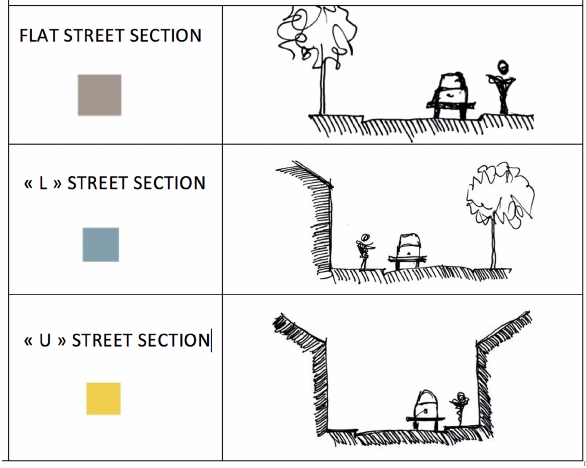
Figure 4: Urban typology map legend